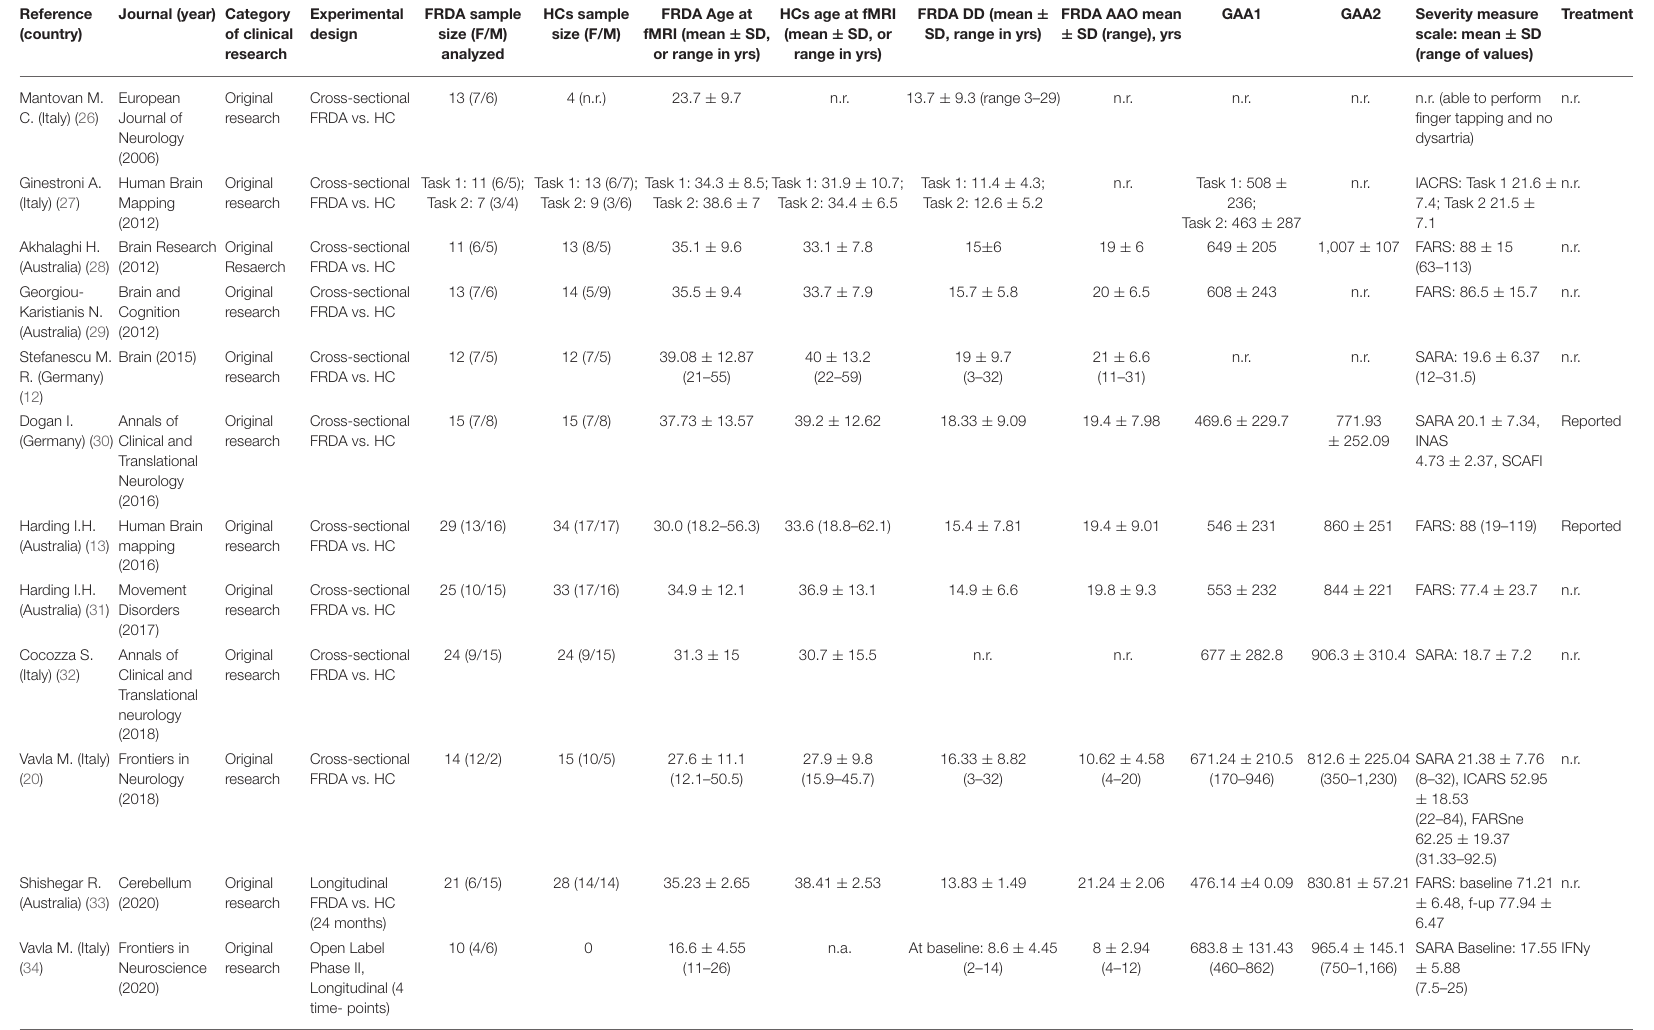
TABLE 1 | Demographic and clinical